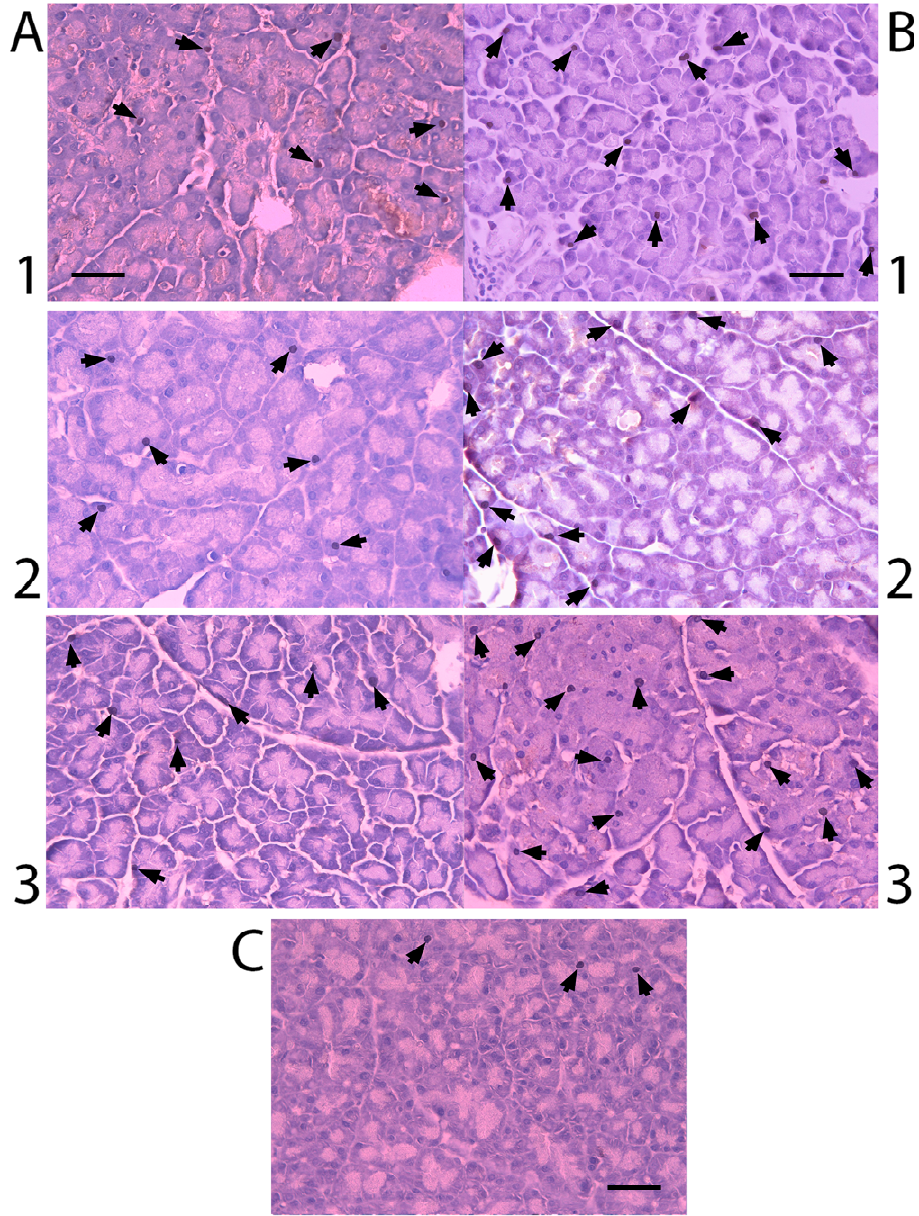
Figure 3. Immunoperoxidase for Nkx6.1 labeling of pancreatectomized rat pancreas (×400 magnification). Staining (arrows) for Nkx6.1. Scale bar = 25 µm. ( A ) untreated groups; ( B ) silymarin treated groups; ( C ) control group, (1) 7 days after pancreatectomy; (2) 14 days after pancreatectomy; (3) 21 days after